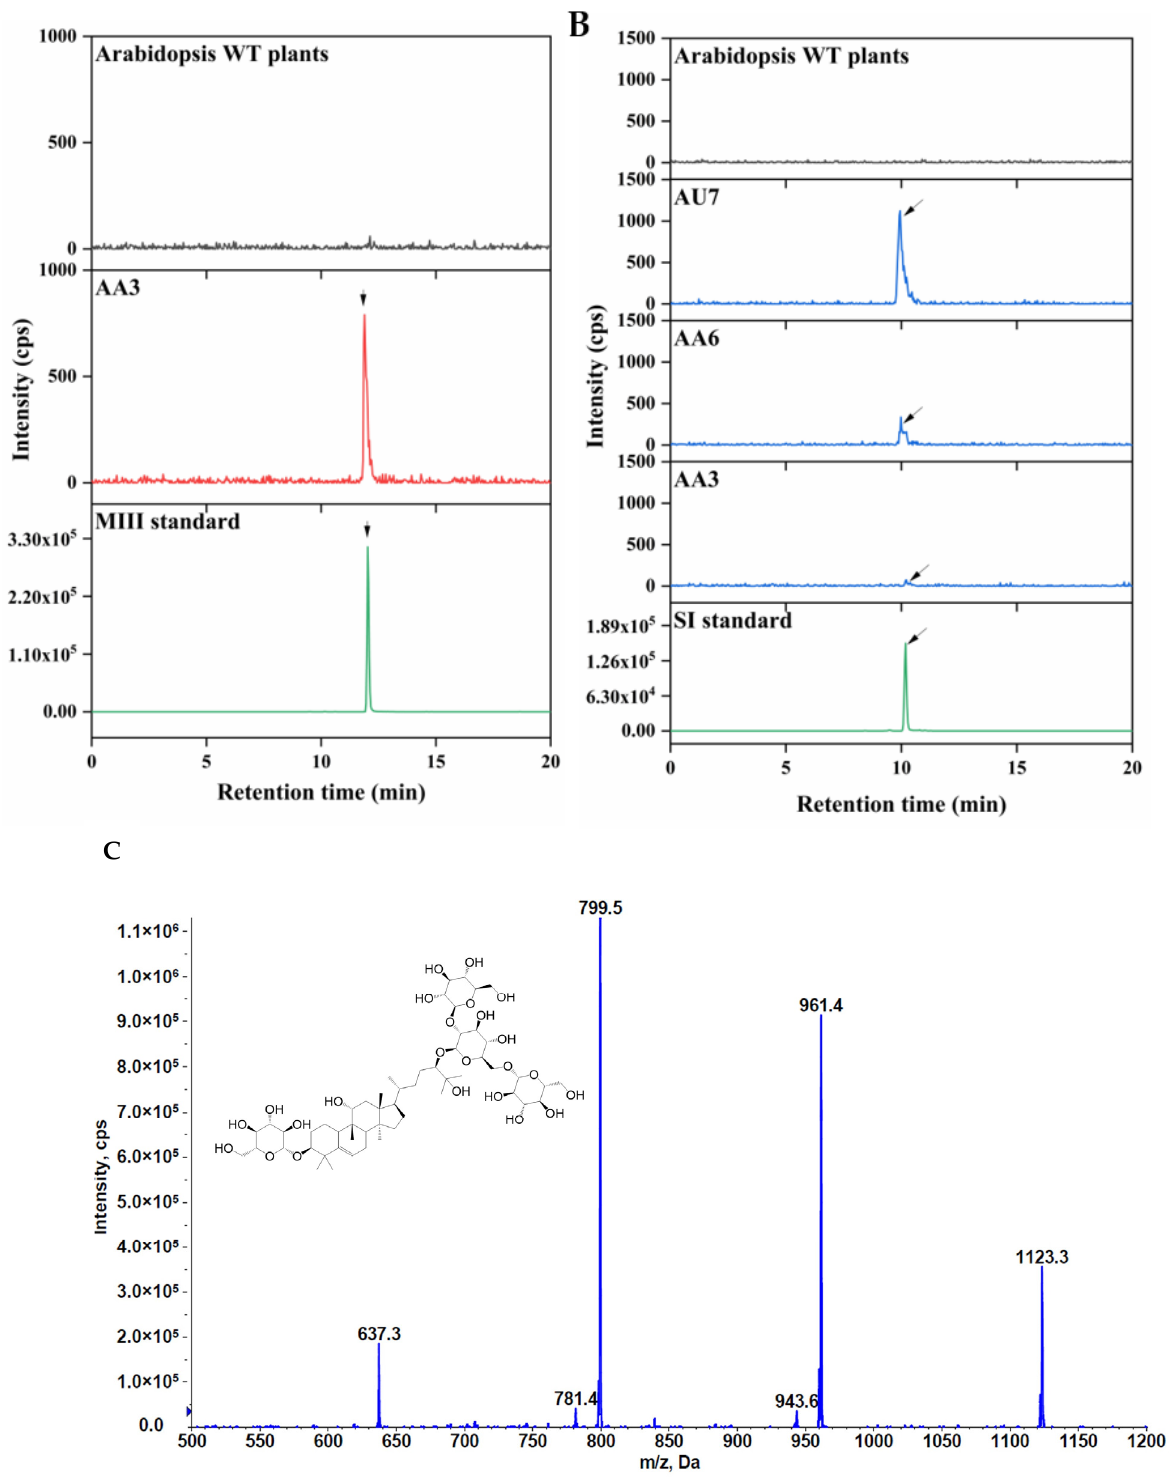
Figure 5. Production of mogrosides in transgenic Arabidopsis lines. ( A ) HPLC-MS/MS analysis of MIII in transgenic Arabidopsis lines. ( B ) HPLC-MS/MS analysis of SI in transgenic Arabidopsis lines. The black arrows indicate the peak of MIII and SI. ( C ) Full-scan product ion of SI.